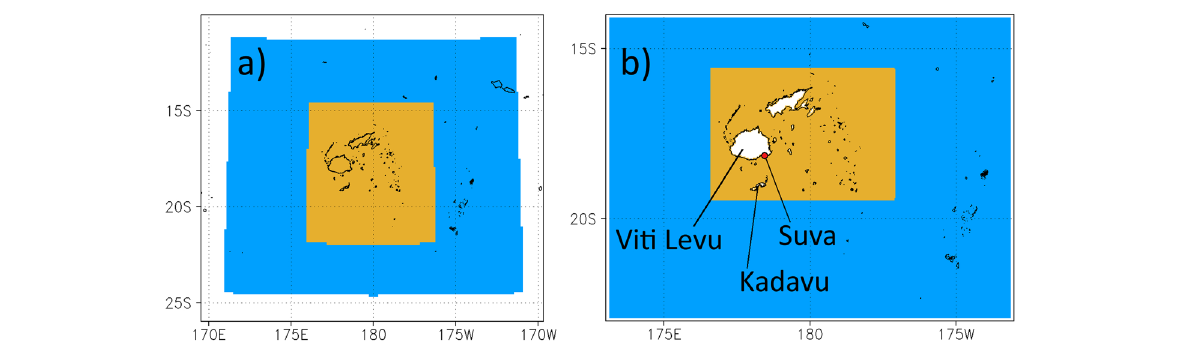
Fig. 1 Domains for the WRF and WW3 simulations. a WRF simulations and b WW3 simulations. The blue and orange areas represent the parent and child domains, respectively